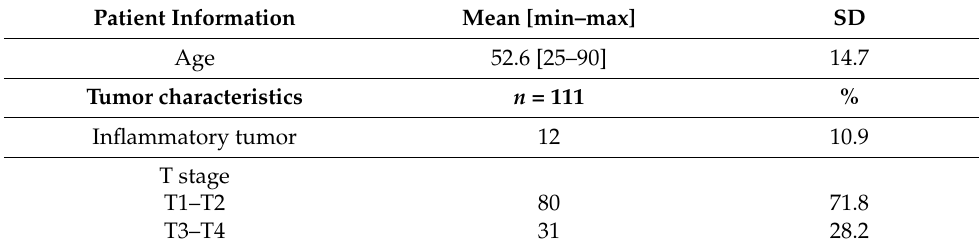
Table 1. Patient Table 1. Patient characteristics.